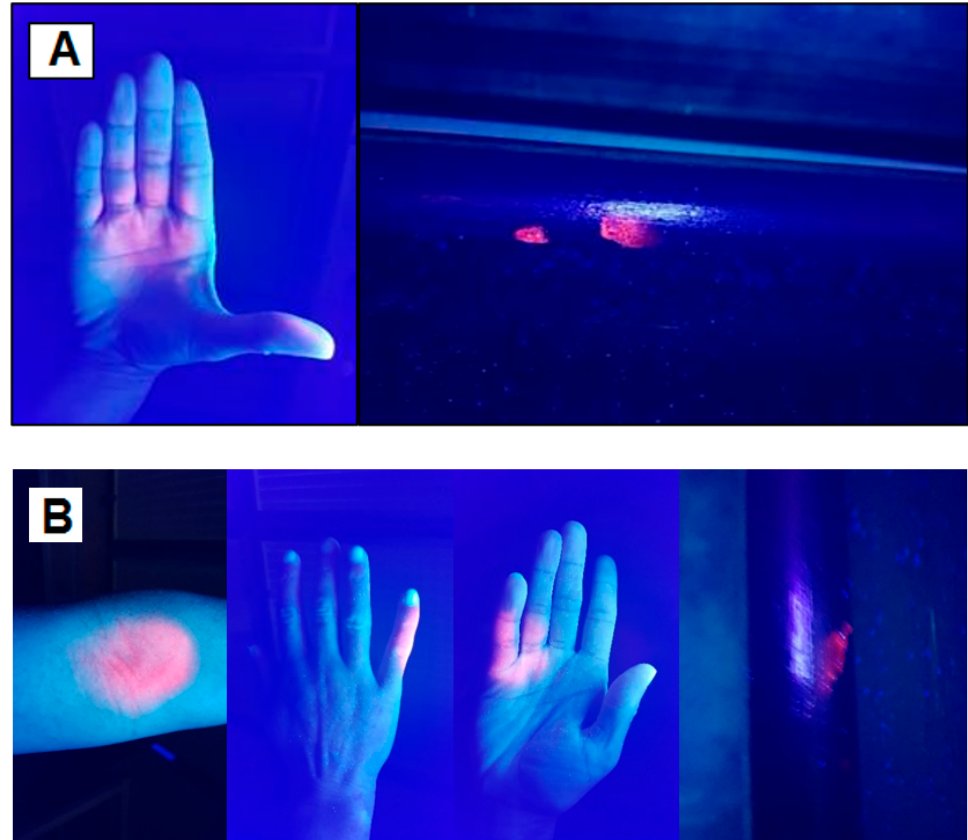
Figure 10. ( A ) A cough into a cupped hand and then contact with a door handle; ( B ) a cough in to a bare inner elbow, hand contamination from arms being crossed so that hand touches contaminated inner elbow and then contact with a door handle.